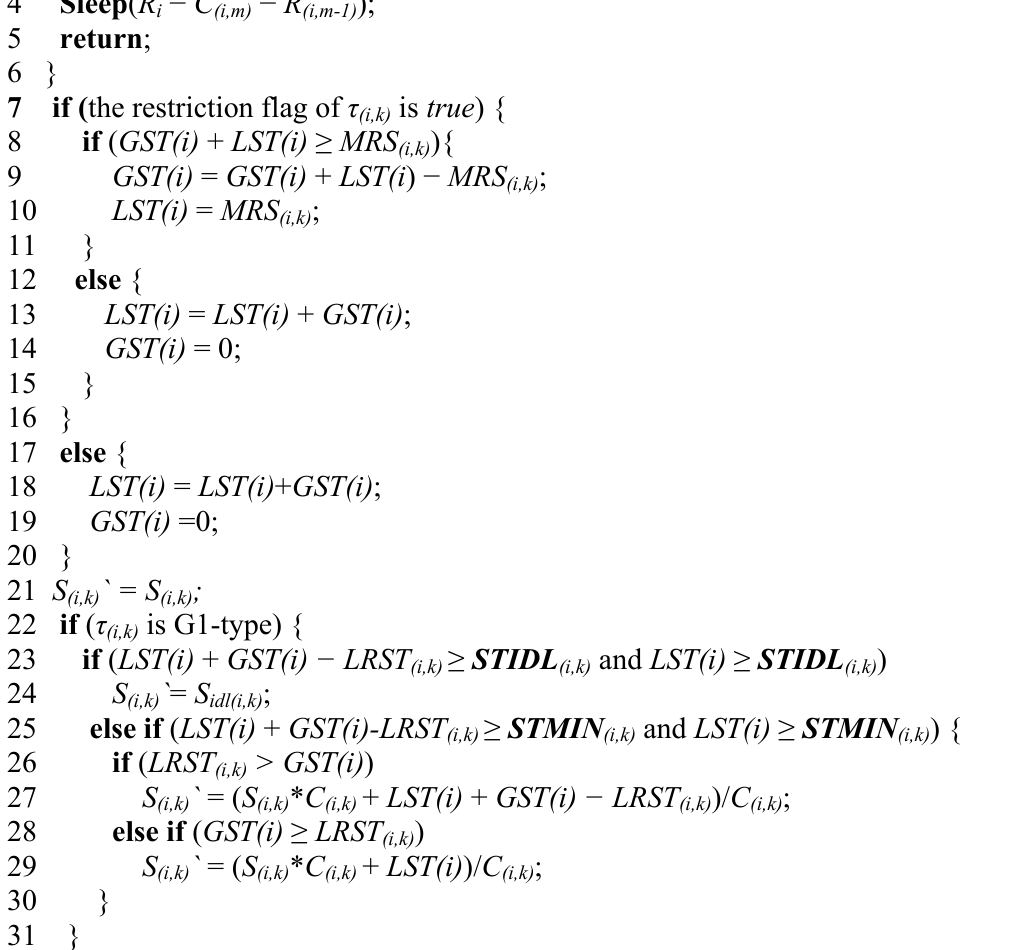
1 Algorithm HTDVS-HRCT